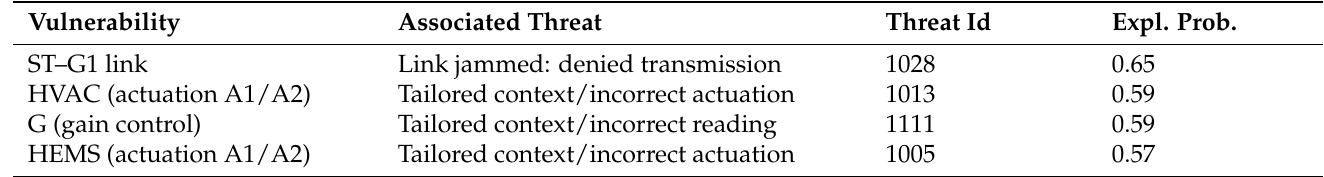
Table 8. Vulnerabilities, exploitation probabilities and associated threats for UC1.